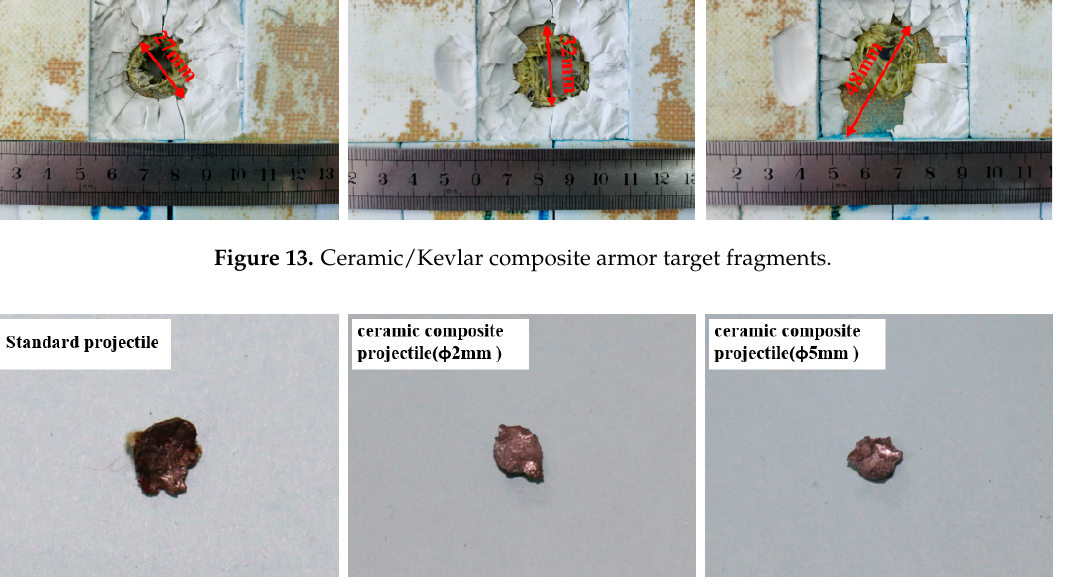
Figure 14. Projectile core residual after the penetration of the Ceramic/Kevlar composite armor.